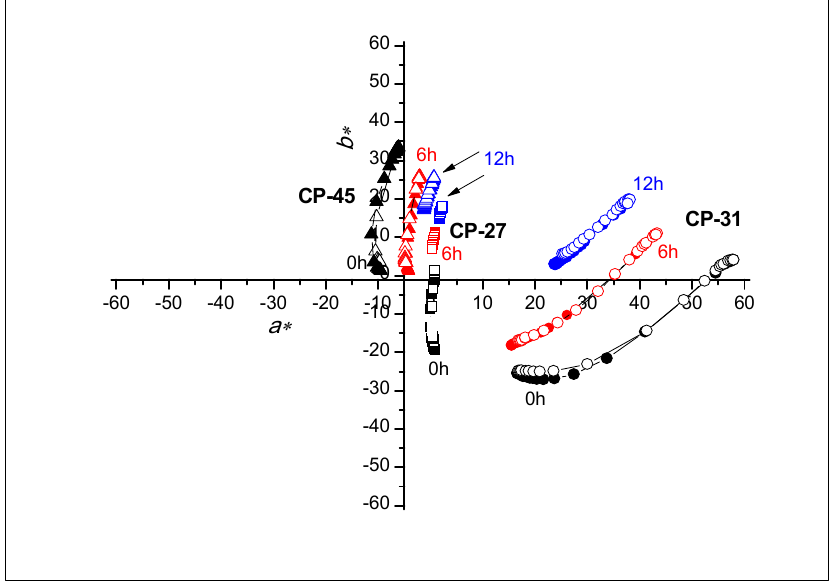
Figure 6. Changing of CIELAB values of all TC inks printed on cellulose-based paper in the ( a * , b * ) plane at heating (solid signs) and cooling (open signs).